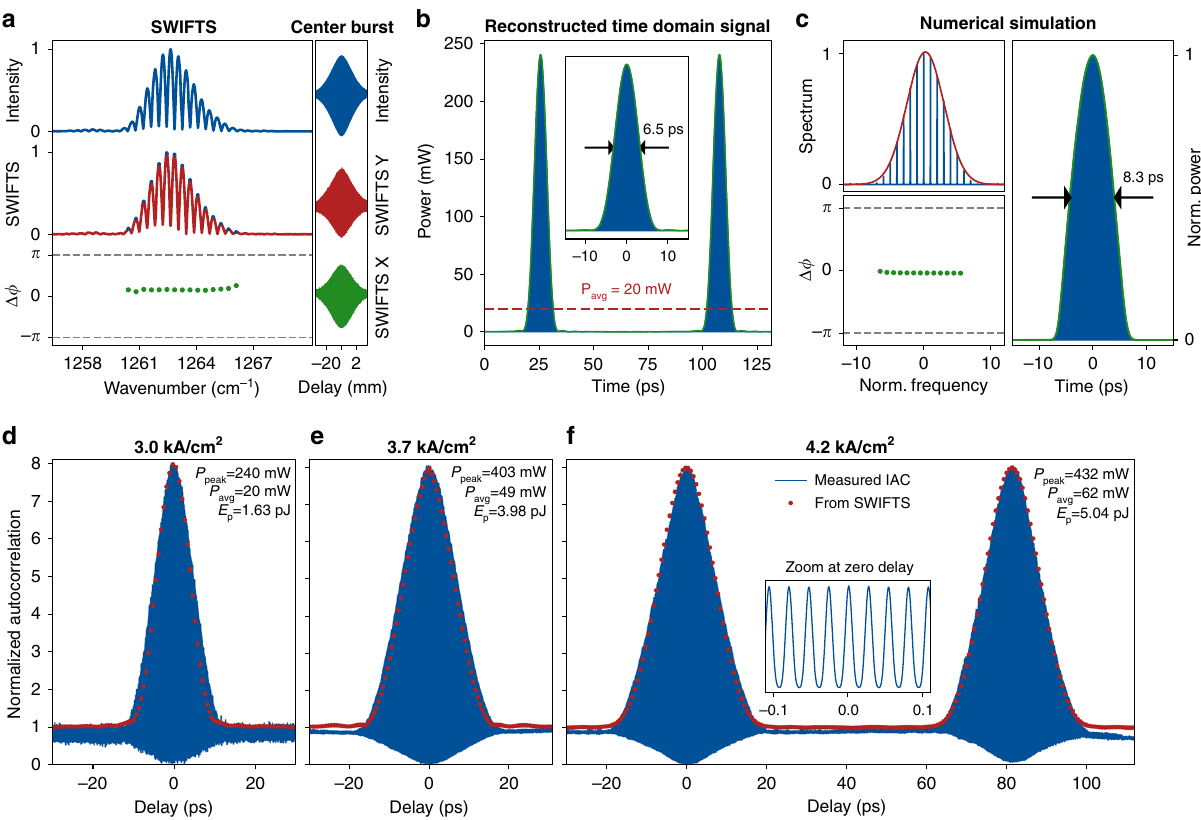
Fig. 2 Mode-locked pulses from an 8 μ m wavelength QCL. a SWIFTS characterization of the QCL operated close to lasing threshold. The laser is modulated at the in-phase synchronization frequency and at 37 dBm power level. b Reconstructed time-domain signal of the QCL showing a train of 6.5 ps short pulses, which is 2.5 ps longer than the shortest pulses generated in THz QCLs 25 . c Simulation of the QCL using the coherent Master equation described in Supplementary Section 1. d Interferometric autocorrelation (IAC) of the QCL pulses close to threshold. Red dots: envelope of the IAC reconstructed using SWIFTS. e IAC at higher current. f IAC at the rollover current, still displaying the 8:1 ratio. The second burst at a delay equal to the cavity roundtrip time is due to the interference of subsequently emitted pulses. Its peak value of 8 provides another proof for the coherence of the pulses because phase-decoherence would smear out the fringes of the IAC and thus decrease the peak value to smaller than 8. Inset: zoom on the interferometric fringes. The DC bias applied to the modulation section was between 3 and 4 V for all measurements shown in this fi